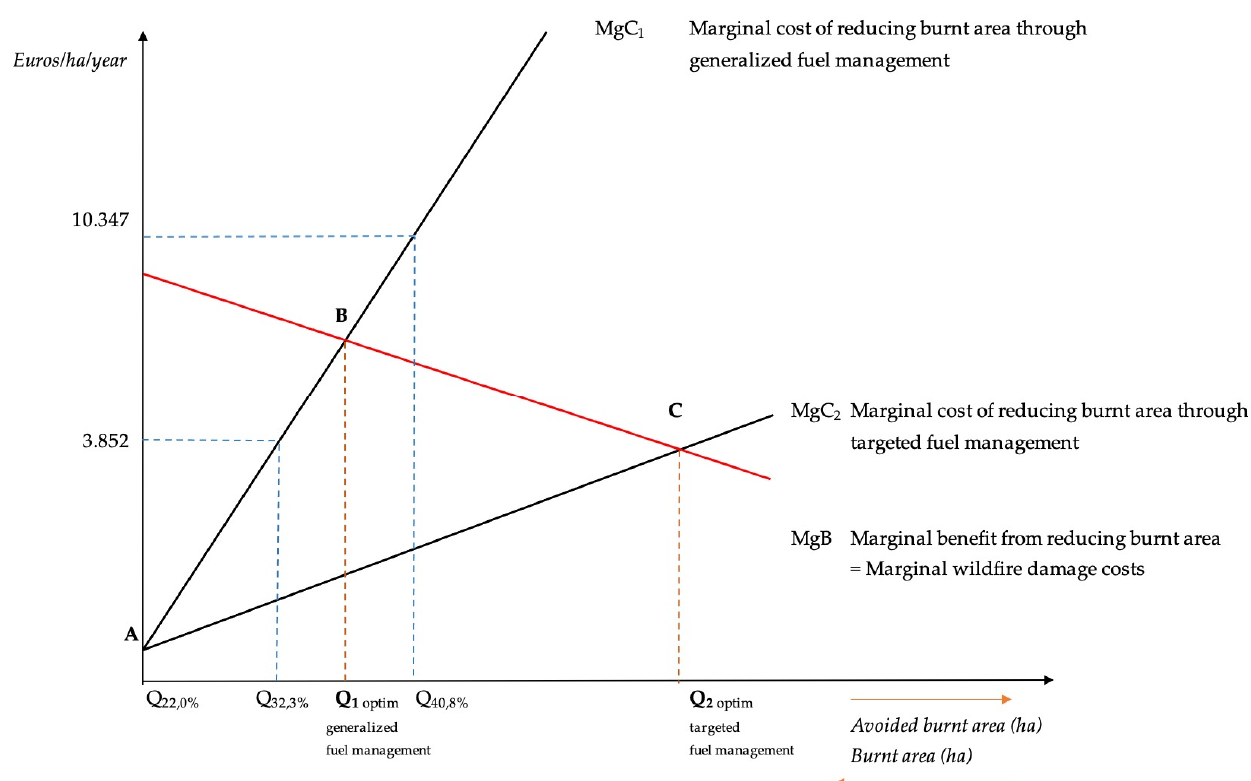
Figure 3. Marginal benefits and marginal costs of avoided burned area (EUR/ha/year). Avoided burnt areas corresponding to three fuel management levels: Q 22.0% = 0, current situation, Q 32.3% , moderate level, and Q 40.8% , high level. Two optimal levels of fuel management: Q 1 , with generalized fuel management, and Q 2 , with targeted fuel management (only where it has the highest effect). Note these are simplified (not empirically estimated) curves, for illustrative purposes alone.